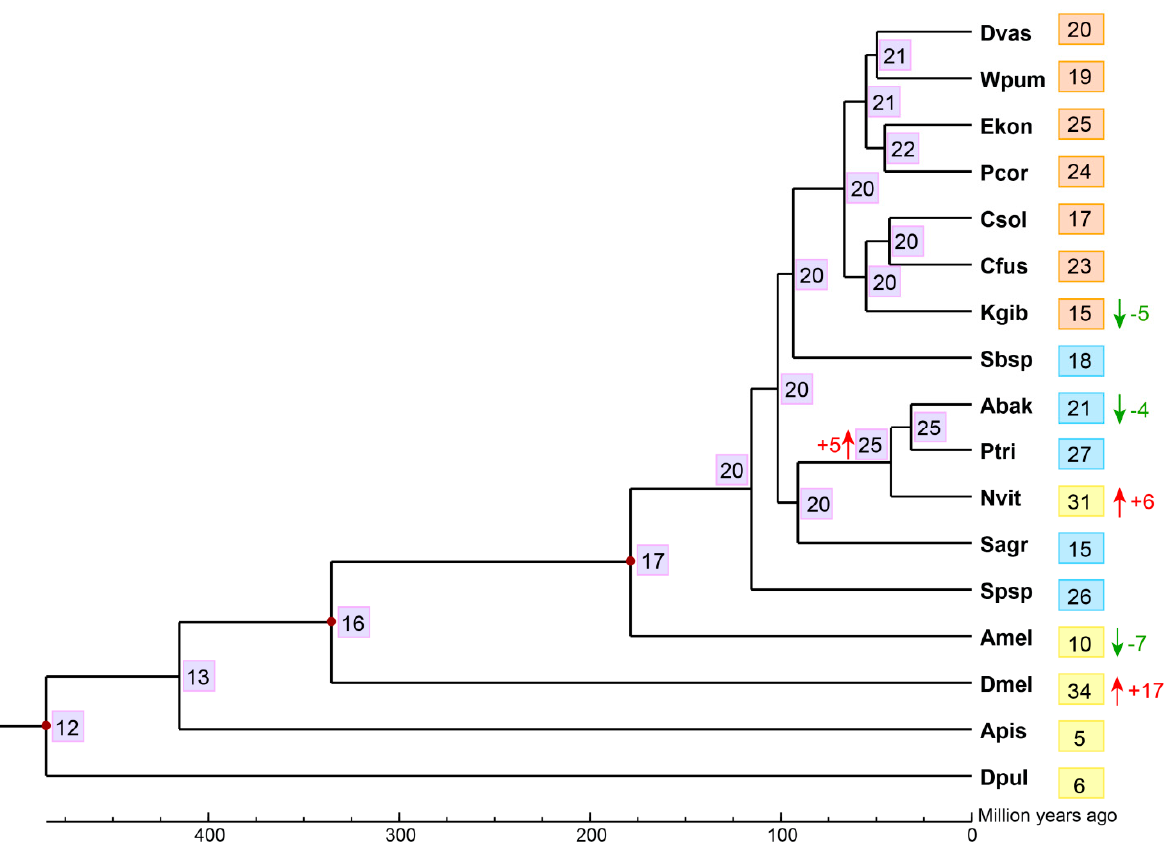
Figure 3. Analysis of gene expansion and contraction of CTLs of fig wasps. The number in the gray background on each node represented the estimated copy number of ancestral CTLs. Dvas, D. vasculosae ; Wpum, W. pumilae ; Ekon, E. koningsbergeri ; Pcor, P. corneri ; Csol, C. solmsi ; Cfus, C. fusciceps ; Kgib, K. gibbosae ; Sbsp, Sycobia sp.2; Abak, A. bakeri ; Ptri, P. tridentata ; Sagr, S. agraensis ; Spsp, Sycophila sp.2; Dmel, D. melanogaster , Amel, A. mellifera ; Nvit, N. vitripennis ; Apis, A. pisum ; Dpul, D. pulex . The numbers in the orange background represented the gene number of CTLs in the corresponding pollinators. The numbers in the blue background represented the gene number of CTLs in non-pollinators. The numbers in the yellow background indicated the number of CTL genes in the corresponding reference species. The red upward arrows indicated gene expansion ( E ‐ value < 0.05), and the green downward arrows indicated gene contraction ( E ‐ value < 0.05).